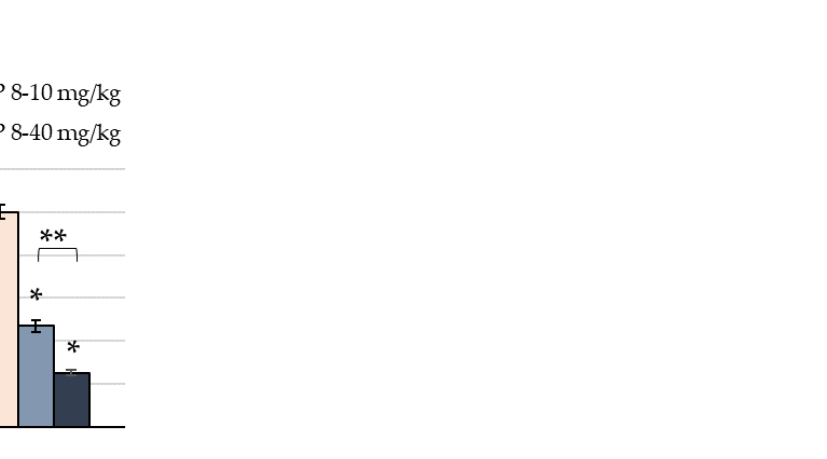
Figure 2. Dopamine concentration in the striatum of mice after two (8 and 10 mg/kg) and seven (8, 10, 12, 16, 20, 26, and 48 mg/kg) injections of 1-methyl-4-phenyl-1,2,3,6-tetrahydropyridine (MPTP) in relation to the control, which was taken as 100%. n = 8 per group. * p < 0.05, significant difference compared with the control (one-way ANOVA). ** p < 0.05, significant difference between the selected parameters (one-way ANOVA). Data are presented as mean ± SEM. Cntr, the control group that received 0.9% NaCl; DA, dopamine.